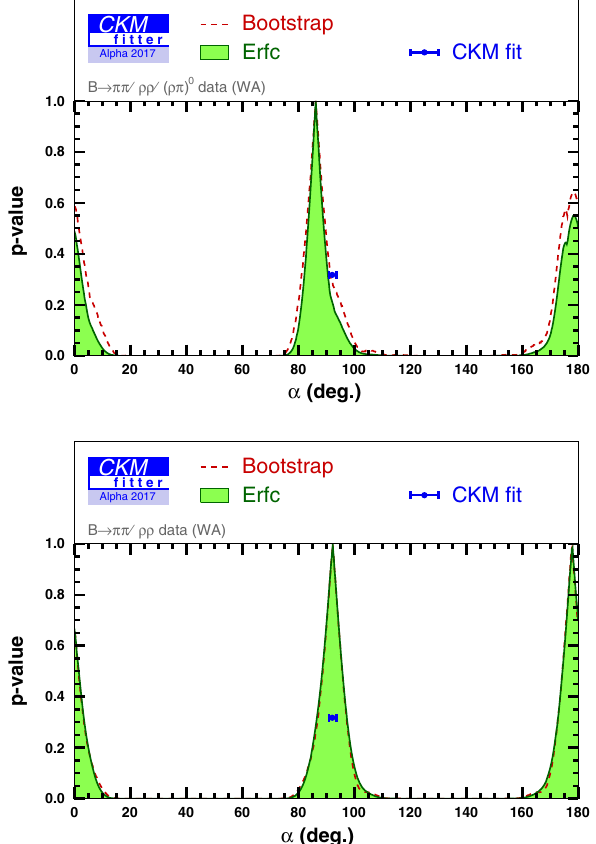
Fig. 18 p value for α comparing the Wilks-based approach (denoted Erfc) and the full frequentist approach based on the bootstrap method, for the combination of the three B → hh decay modes ( top ) and for the partial combination based on B → ππ and B → ρρ only ( bottom )